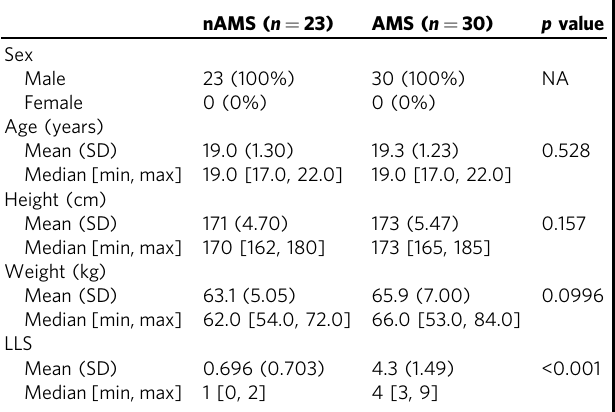
Table 1 Baseline characteristics of the 53